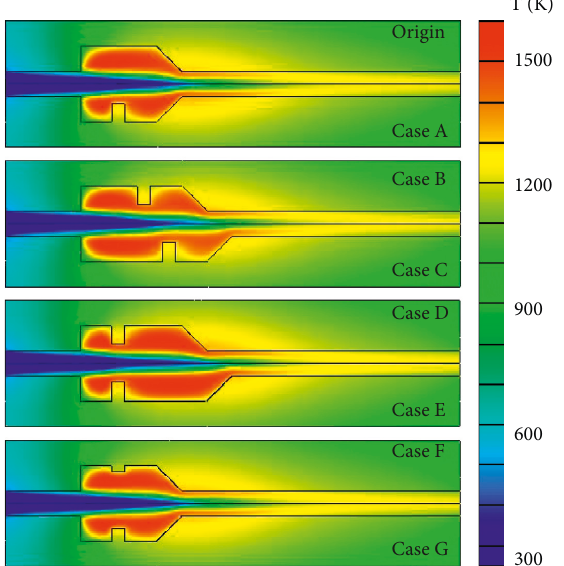
Figure 9: Temperature distribution in the different combustor; the inlet velocity is 10m/s.